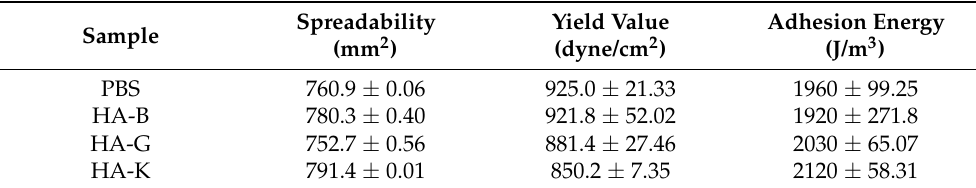
Table 1. Physicochemical properties of HA ointments (mean ± SEM, n = 3, ANOVA, Tukey-Kramer post hoc test, no significant difference at p <